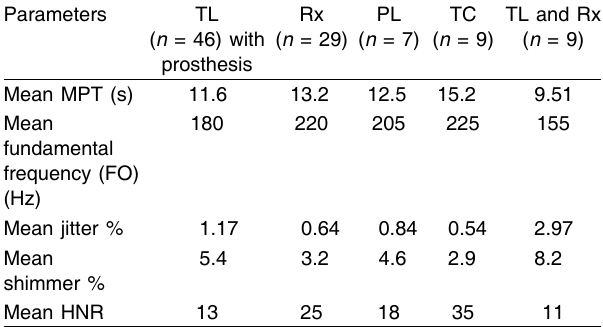
Table 6 Results of voice analysis using CSL